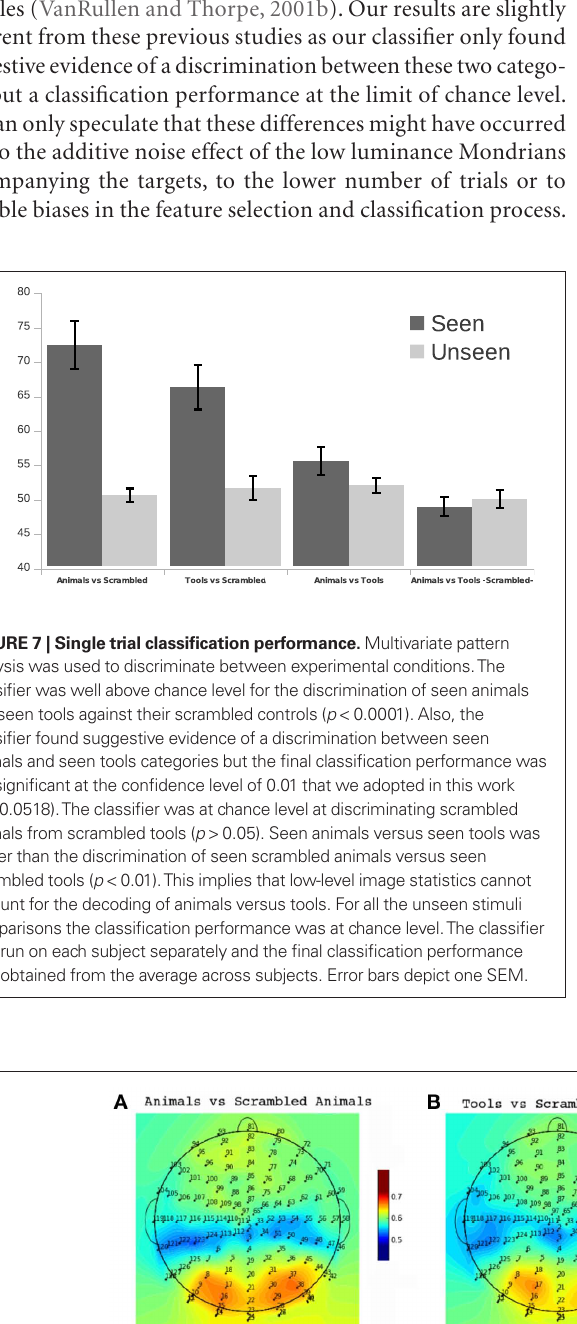
comparisons of meaningful pictures against meaningless pictures (A,B) the occipital electrodes were of most importance. These occipital electrodes were not determinant for subtler semantic categorizations (C) .